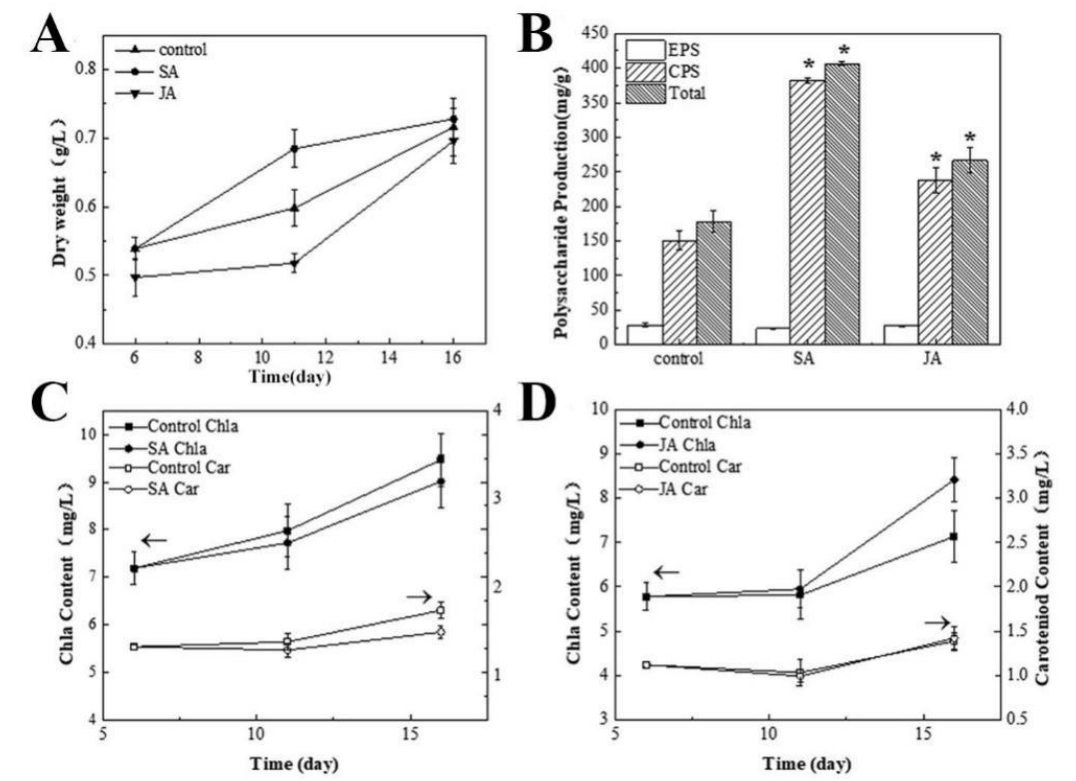
Figure 1. The effects of SA and JA on the biomass ( A ), polysaccharide production ( B ), and photosyn- thetic pigments ( C , D ) of N. flagelliforme . * p < 0.05, compared with the control group. Table 2. The basic physicochemical properties of the control-CPS, SA-CPS, and JA-CPS. Basic